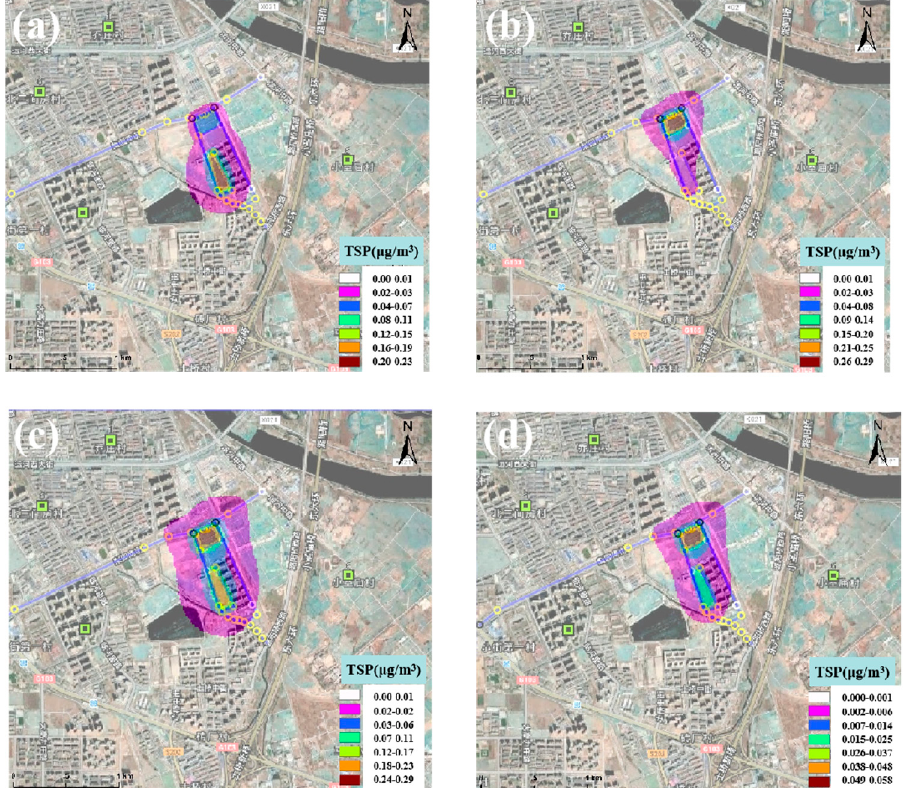
Figure 4. TSP concentration distribution diagram after adding ( a ) fence interception nets, ( b ) bare ground mesh nets, ( c ) road dust suppressants, and ( d ) the above three dust-suppression measures. (Note: The non-English terms in the diagrams were the street names in Beijing).